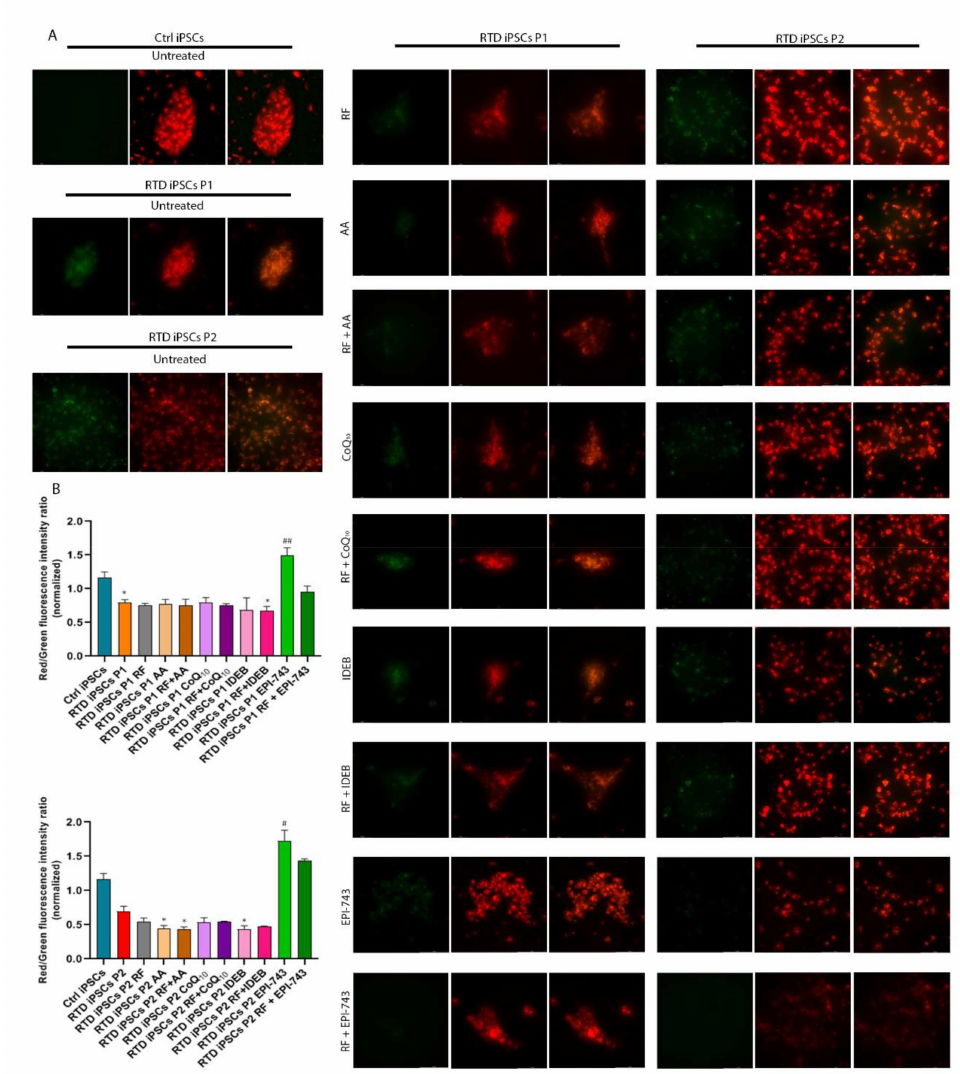
Figure 2. RTD iPSCs show increased lipid peroxidation. ( A ) Fluorescence micrographs of iPSCs labeled with BODIPY using the green (on the left, indicating oxidation of the butadienyl portion of the dye) and the red (on the middle) filter and then overlay of the red (nonoxidized) and green (oxidized) images (in the right column). Colocalization of oxidized and reduced BODIPY fluorescence appears in yellow. Bar = 100 µ m. Control and RTD iPSCs were incubated for 45 min with BODIPY 581 / 591 C11. Treatment with EPI-743, but not other antioxidants, results in significantly reduced levels of oxidized lipids as shown by the shift of green to red fluorescent signal. ( B ) Bar graph reporting the quantitative analyses of the BODIPY experiments performed on control and RTD iPSCs. Values are expressed as mean ± SEM. According to Kruskal-Wallis test * p < 0.05 compared with controls iPSCs; # p < 0.05, ## p < 0.01, respect to untreated